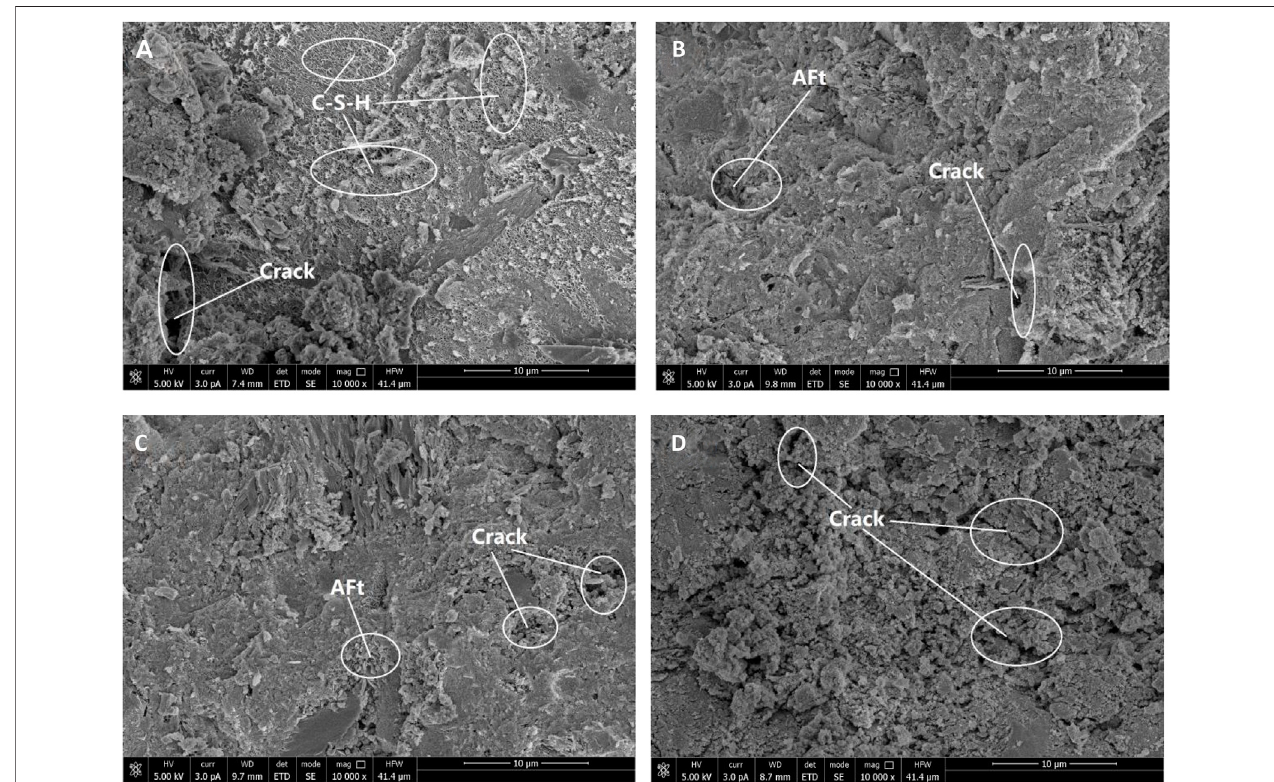
FIGURE 6 | Microscopic morphology of each group of concrete with 20 cycles: (A) MK0; (B) MK5; (C) MK10; (D) MK15.